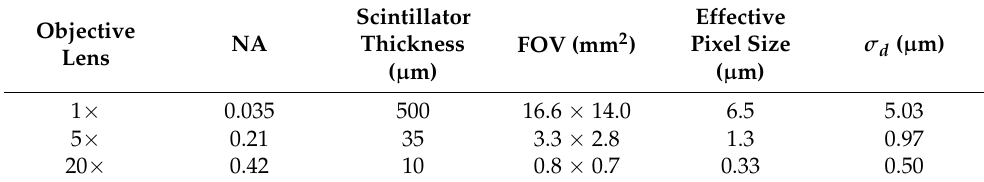
Table 1. The calculated detector standard deviation, σ d , for MCT white-beam